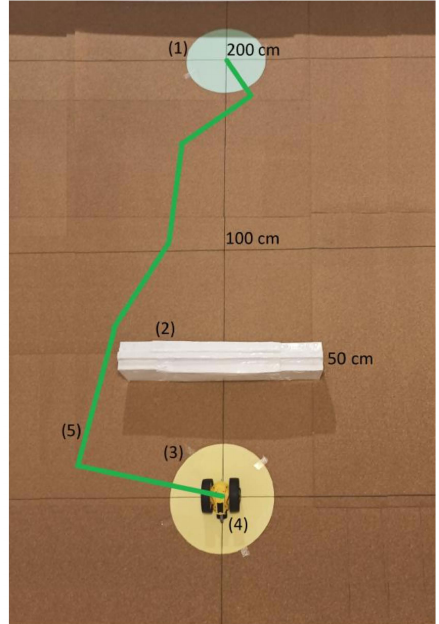
Figure 9. Trajectory in scenario with one obstacle: (1) goal, (2) obstacle, (3) home, (4) robot, and (5)